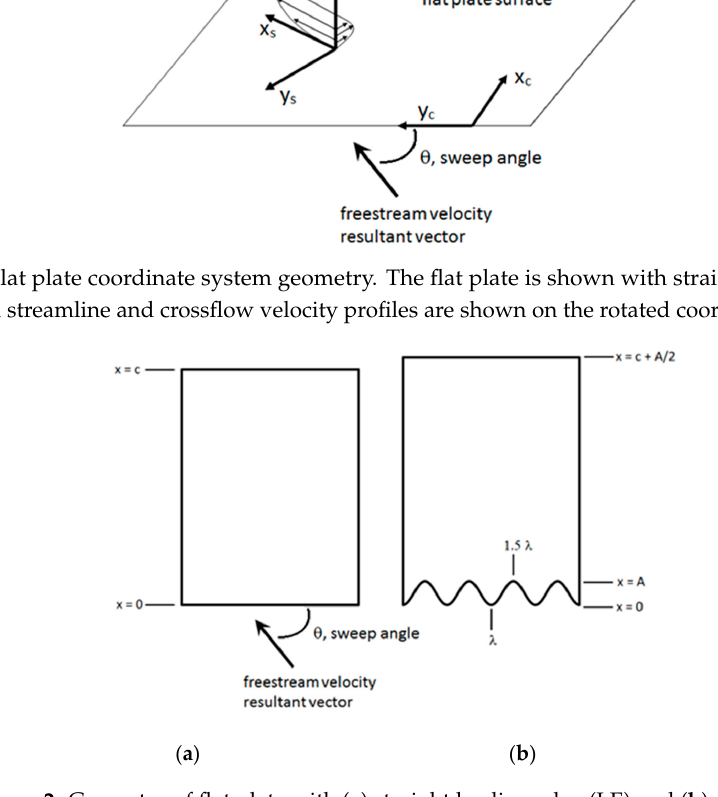
Figure 2. Geometry of flat plate with ( a ) straight leading edge (LE) and ( b ) wavy LE.